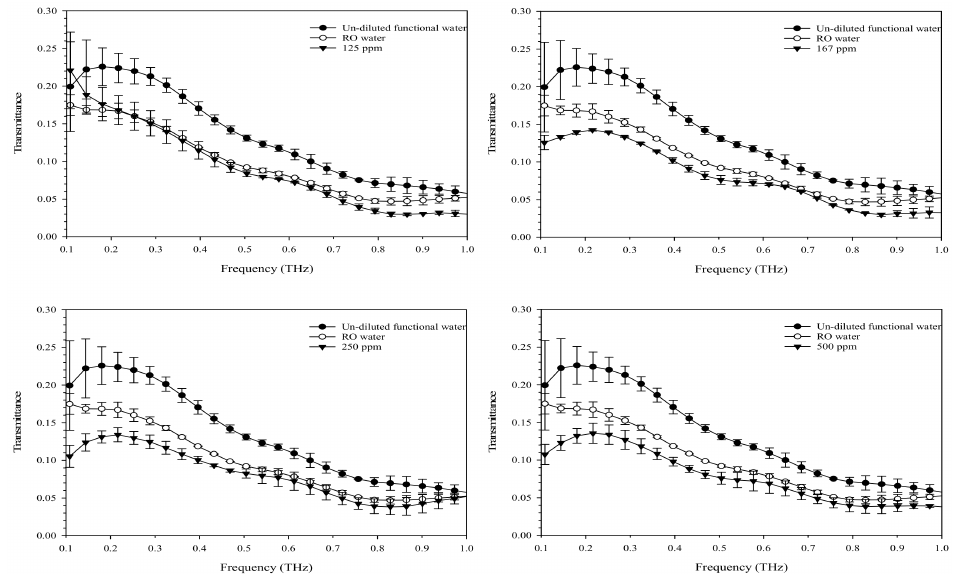
Figure 7. Optical properties of the terahertz-based functional mineral water. The terahertz-based functional mineral water was diluted with RO water and scanned with terahertz time-domain spectroscopy in the frequency range of 0.1–1